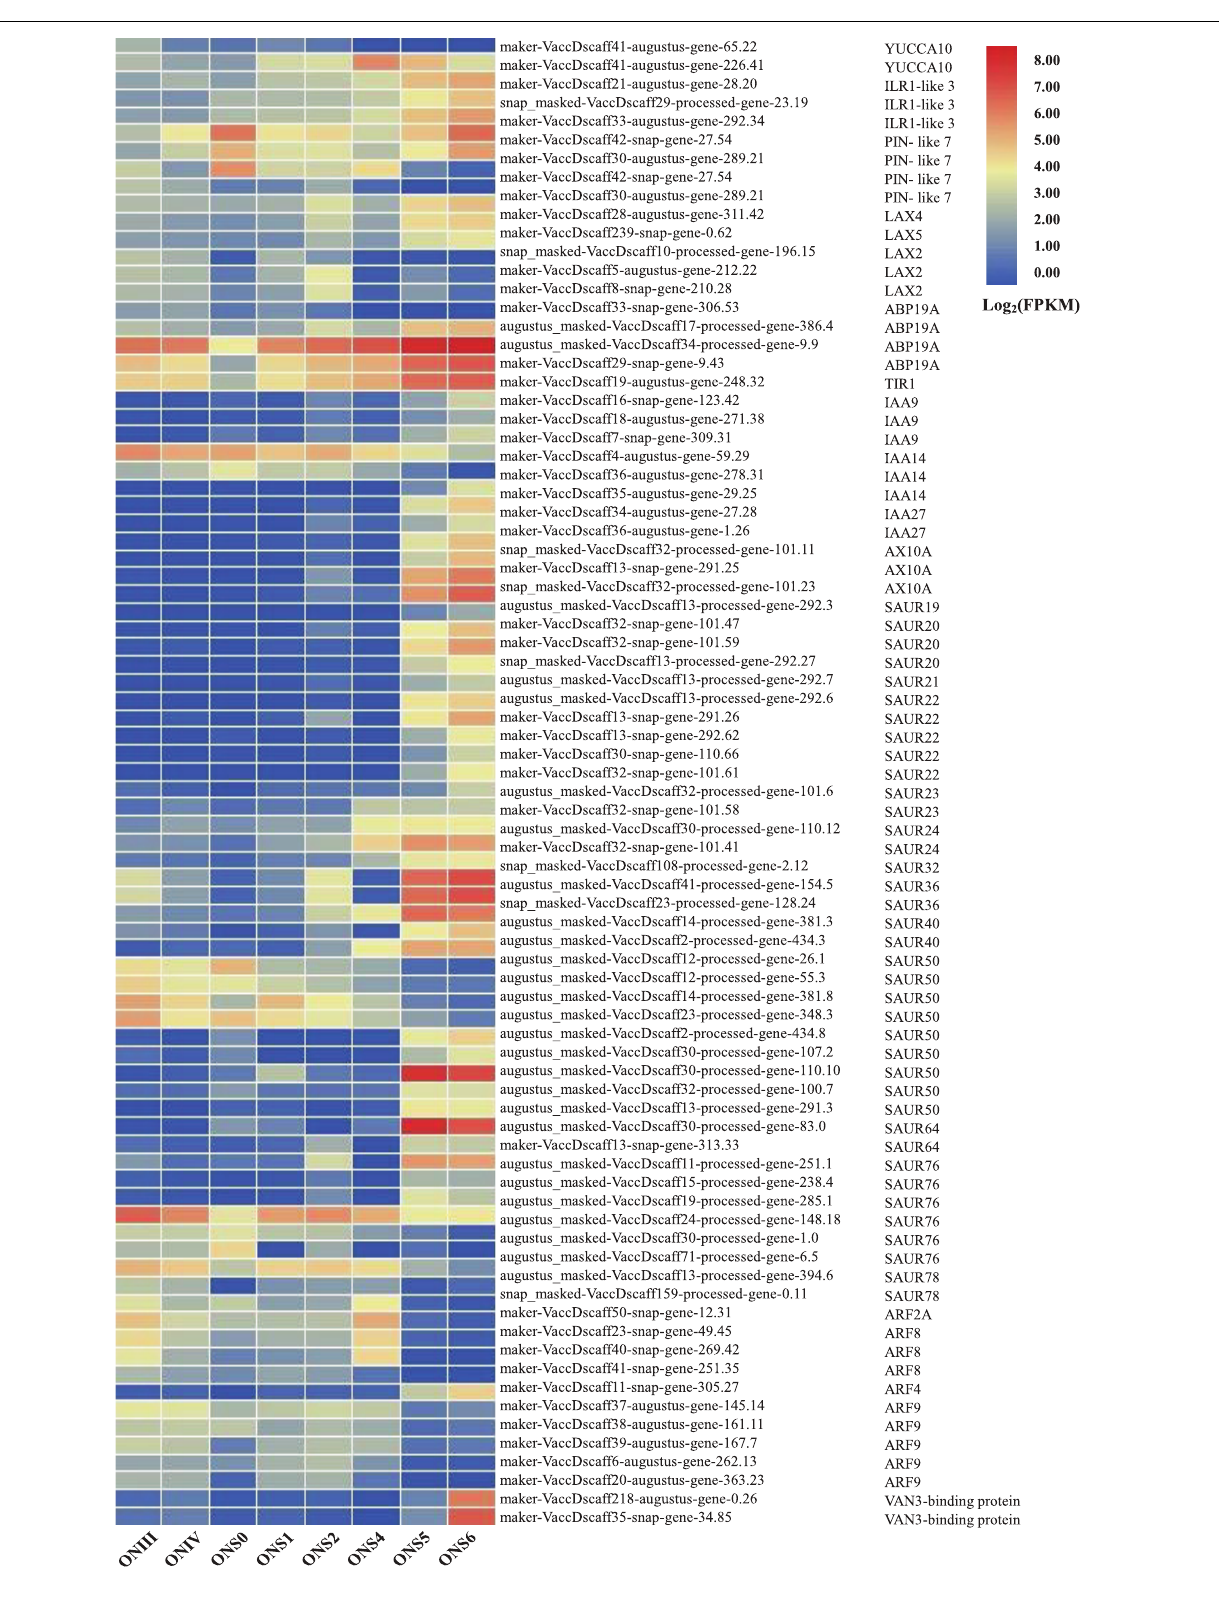
Frontiers in Plant Science |